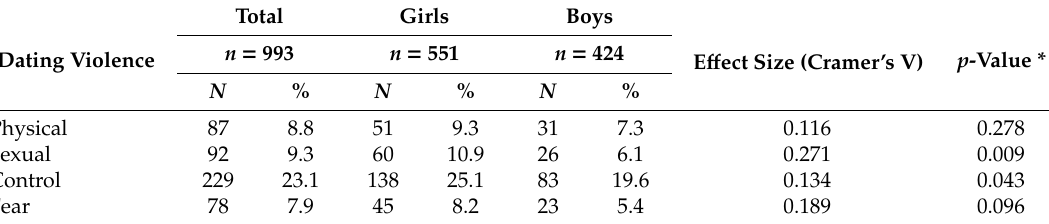
Table 2. Prevalence of dating violence victimization.